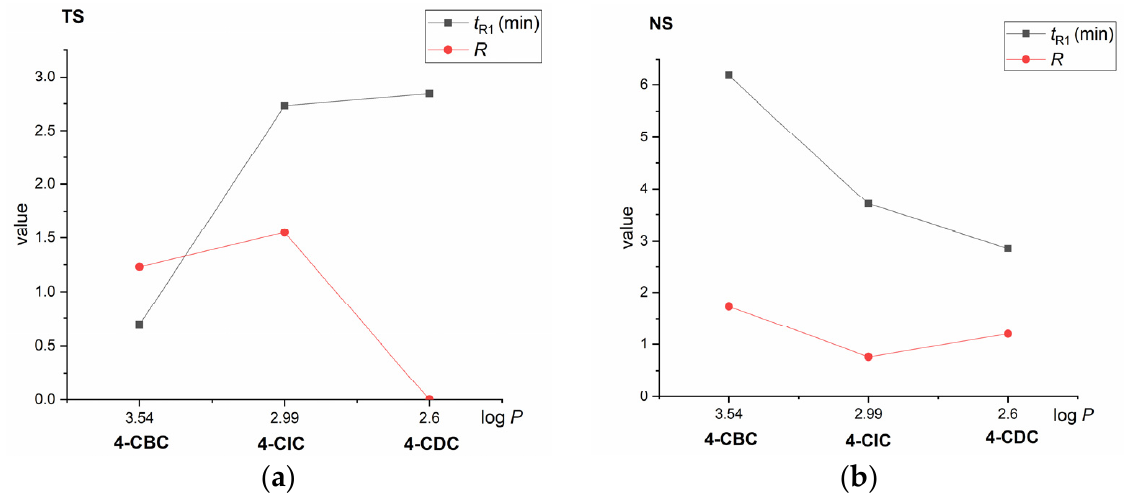
Figure 6. Dependencies of retention ( t R1 ) and resolution values ( R ) on polarity (log P ) of derivatives of cathinone on the TeicoShell (TS) (a) and NicoShell (NS) (b) columns. MP composition: CO 2 /MeOH/H 2 O (80/20/1.0, v / v / v ); flow rate 1.00 mL min − 1 ; column temperature 25 °C; BP 13.8 MPa; UV detection 254 nm (TS) and CO 2 /EtOH/PrOH/TFA/TEA (85/13/2/0.2/0.2, v / v / v / v / v ); flow rate 1.20 mL min − 1 ; column temperature 25 °C; BP 13.8 MPa; UV detection 220 nm (NS). Lines are to guide the eyes